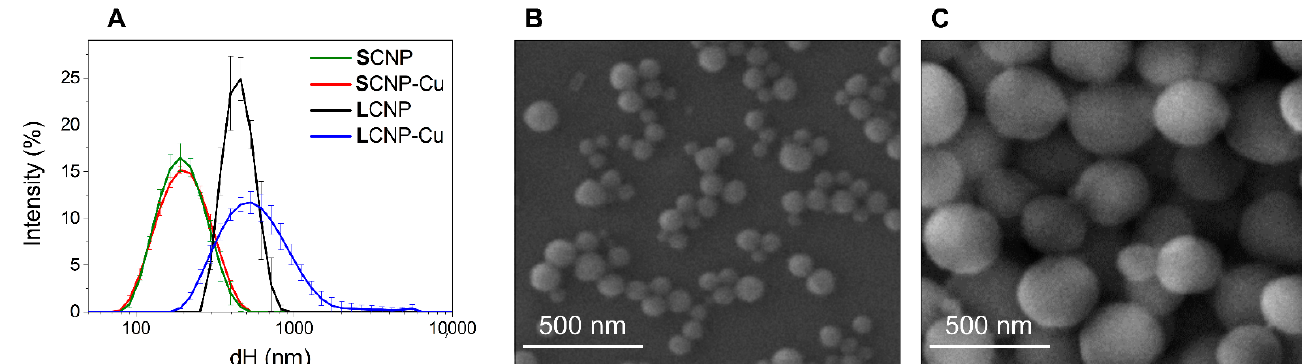
Figure 1. Size distribution of CNPs. ( A ) Hydrodynamic diameter distribution, as evaluated by DLS of pristine and Cu-loaded CNPs suspended in water. Each line is the mean of five measurements of the same suspension. Error bars represent the SD. ( B , C ) FE-SEM images of ( B ) SCNP and ( C ) L CNP. The mean Feret’s diameter of SCNP and LCNP, as assessed by FE-SEM, was 88 ± 22 nm and 242 ± 86 nm, respectively. FE-SEM and TEM analysis revealed that all particles exhibited a spherical shape (see Figure 1B,C and Figure S2 in Supplementary Materials).